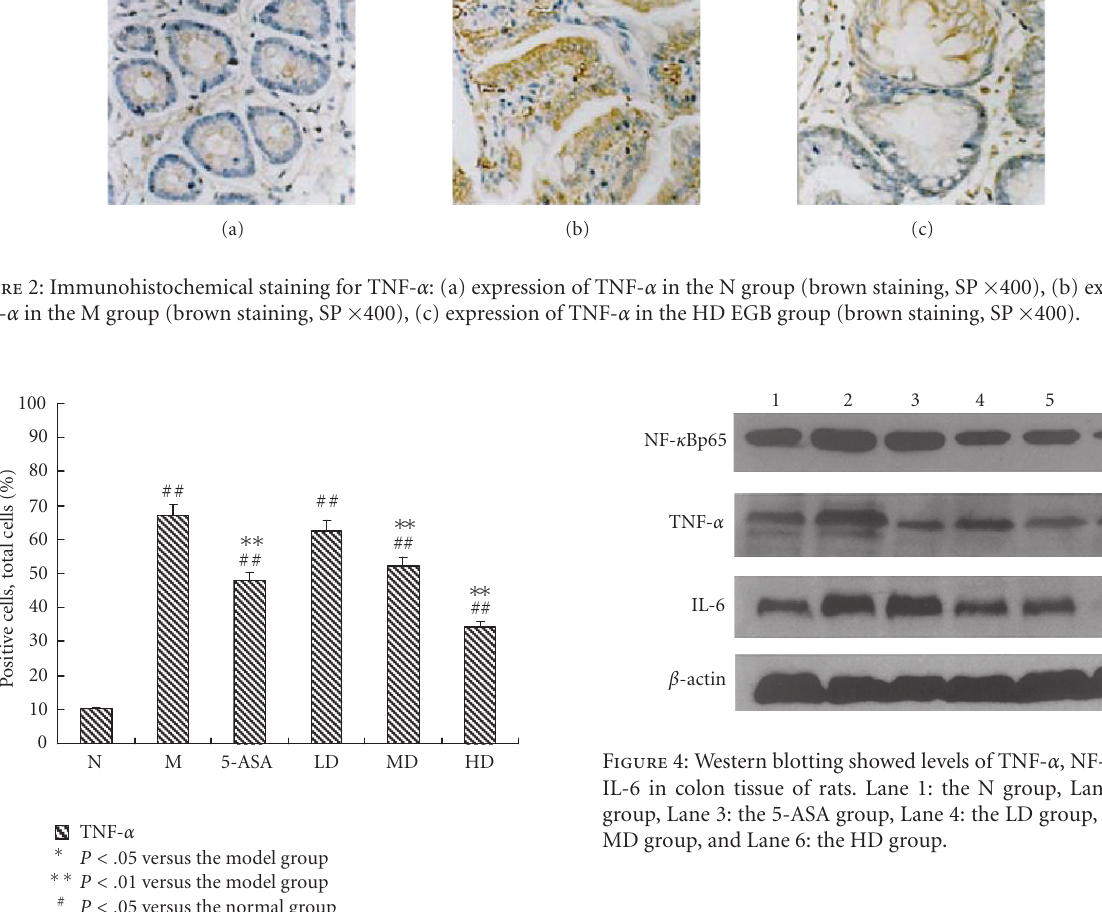
Figure 3: Expression of TNF- α immunohistochemical staining sec- tions in each group. The percentage of positive cells in ten randomly selected fields under high-power microscope (400-fold magnifica- tion) for each sample. The expression of TNF- α in the N group was weak; it was elevated significantly in the M group. EGB treatment suppressed the expression of TNF- α in a dose-dependent manner to some degree, but still higher than normal group. The results were SD. expressed as means (cid:0)